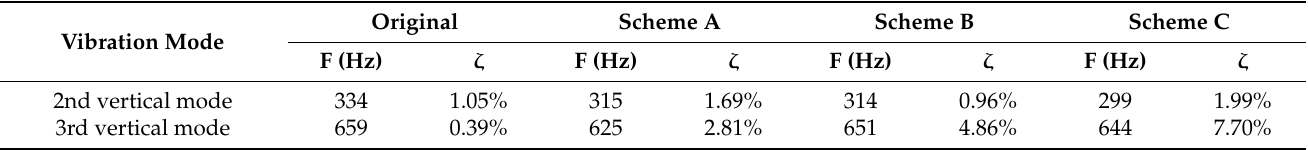
Table 7. Comparison of the damping ratio of pantograph strips.